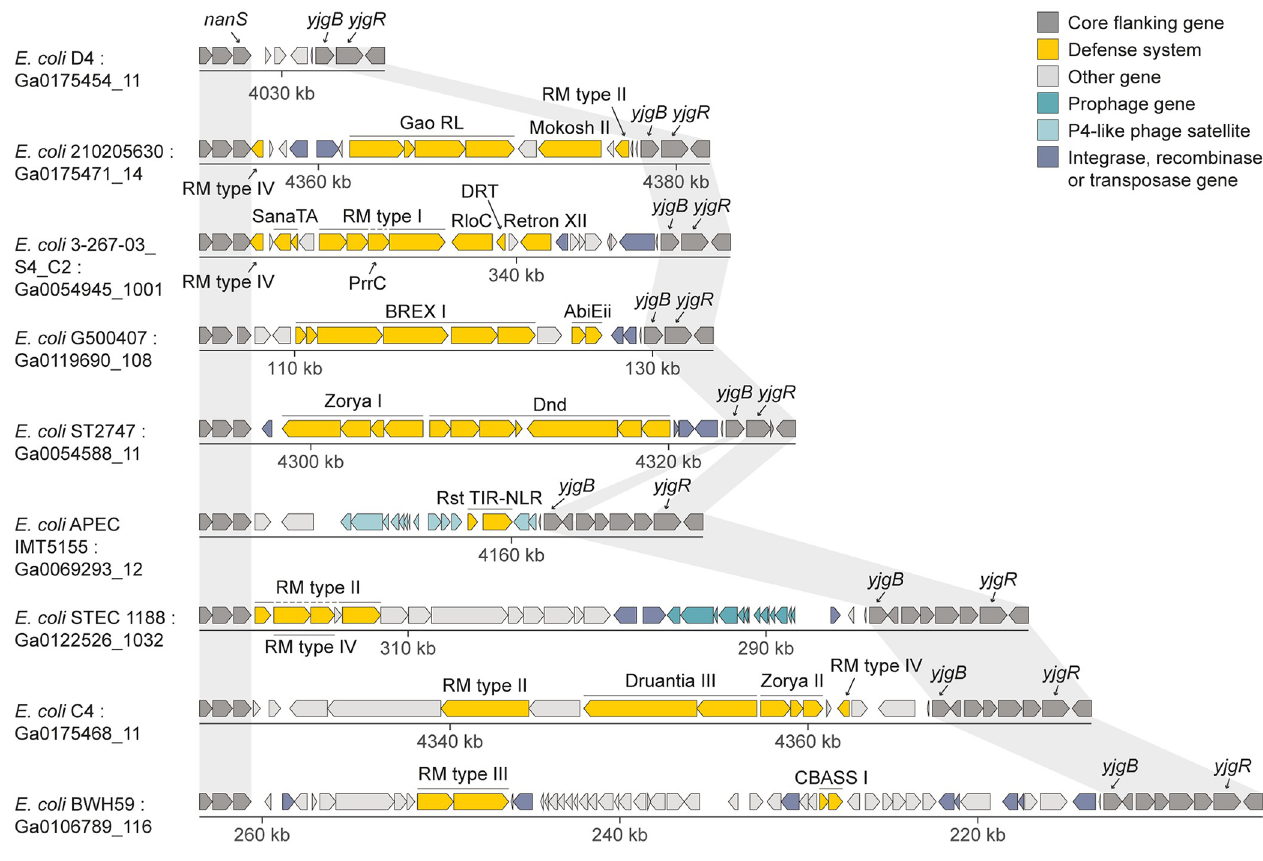
Fig 6. Hotspot #37 contains an extraordinary diversity of defense systems. This hotspot is occupied in E. coli